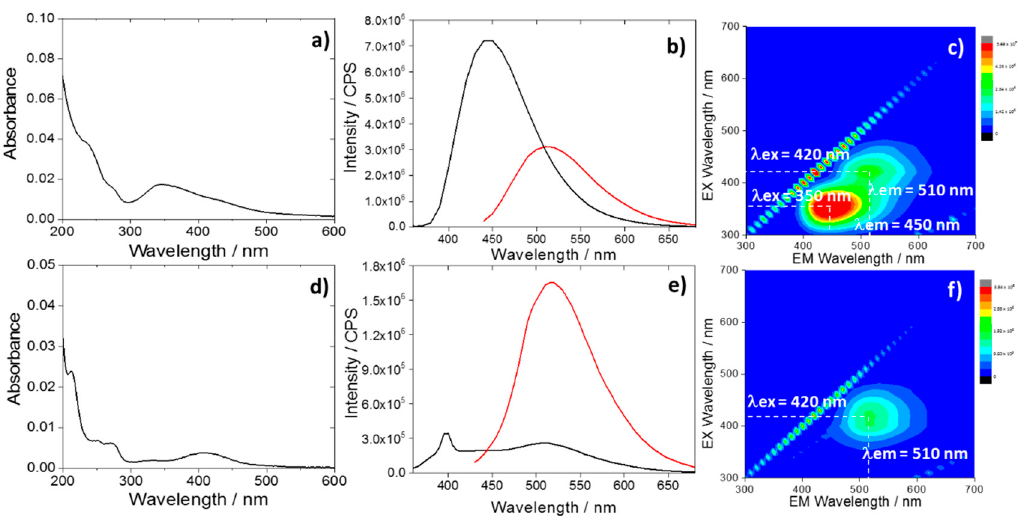
Figure 1. Ultraviolet–visible (UV–Vis) spectra of the CU2 ( a ) and CU25 ( d ) C-dots dispersed in water at a concentration 1 mg L − 1 ; ( b ) and ( e ) photoluminescence (PL) emissions of CU2 and CU25 C-dots in water (1 mg L − 1 ) with excitations at 350 nm (black) and 420 nm (red). The peak at 398 nm under excitation at 350 nm is due to the Raman signal of water. ( c ) and ( f ) 3D photoluminescence spectrum (excitation (y-axis), emission (x-axis), intensity (false colors scale)) of the CU2 and C25 C-dots in water (C-dots concentration = 1 mg L − 1 ).